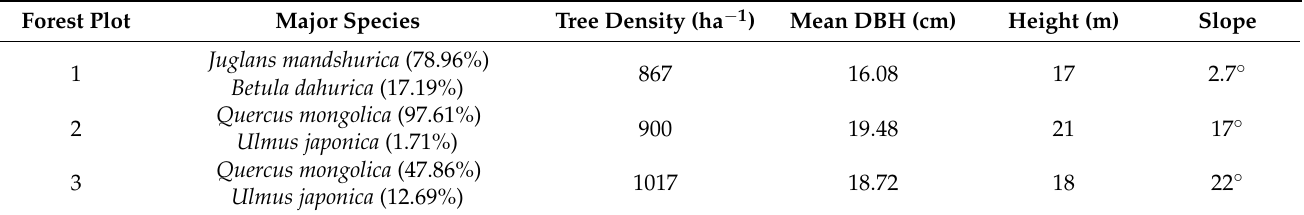
Table 1. General characteristics and species composition of the three deciduous broadleaf forest plots.